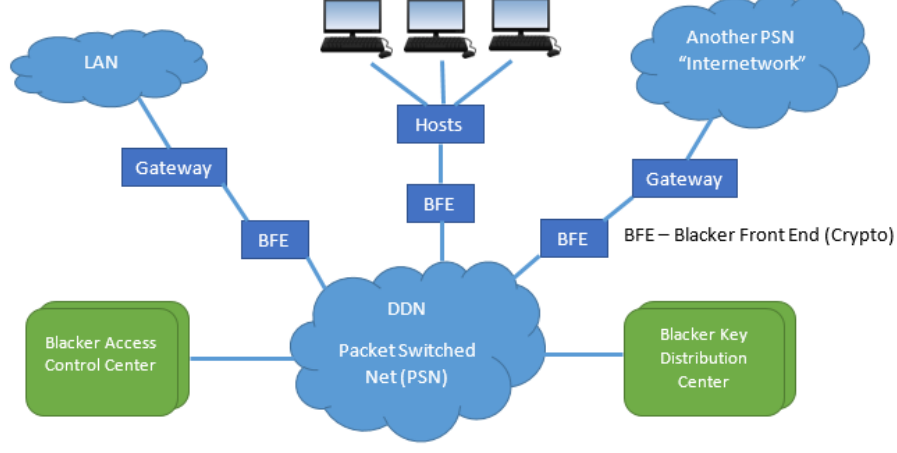
Figure 4. BLACKER-Defense Data Network (DDN) architecture.